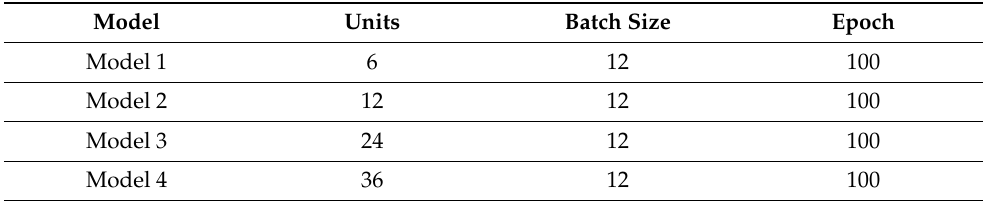
Table 5. Parameter combinations for the top four models.